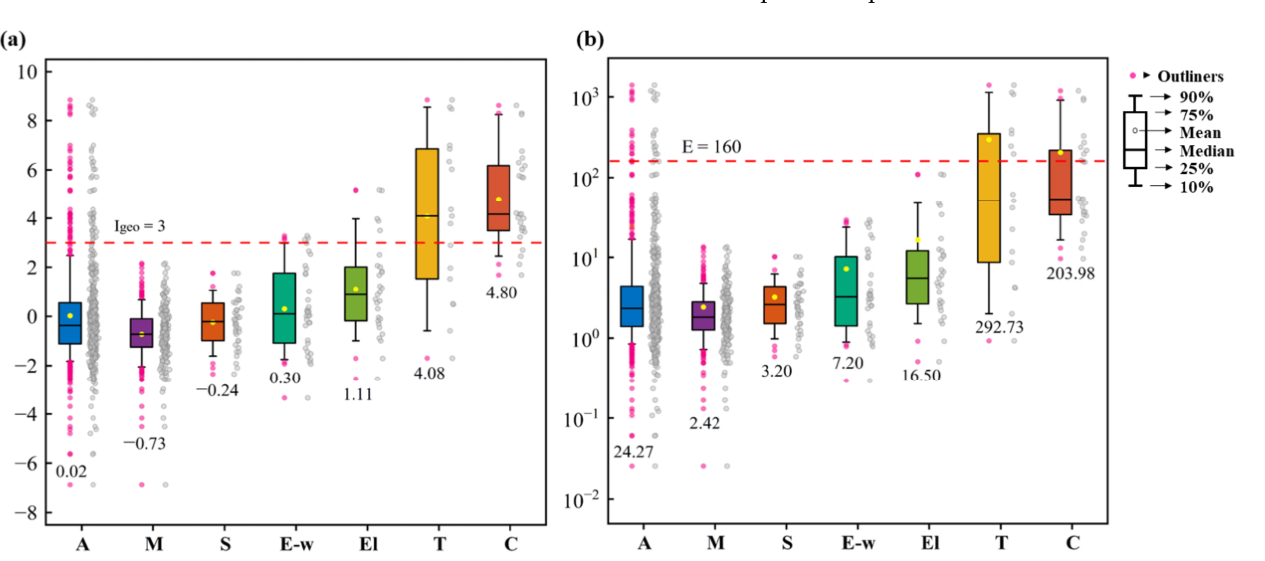
Figure 2. Boxplot of the ( a ) I geo and ( b ) E of all the collected regions and for different region types. (A: all the collected regions; M: mining areas; S: heavy metal processing and smelting areas; E-w: E-waste treatment and disposal sites; El: electroplating sites; T: tanning and the tannery sludge storage sites; C: Cr salt production and chromite ore processing residue disposal areas. The number below each boxplot represents the mean value.).